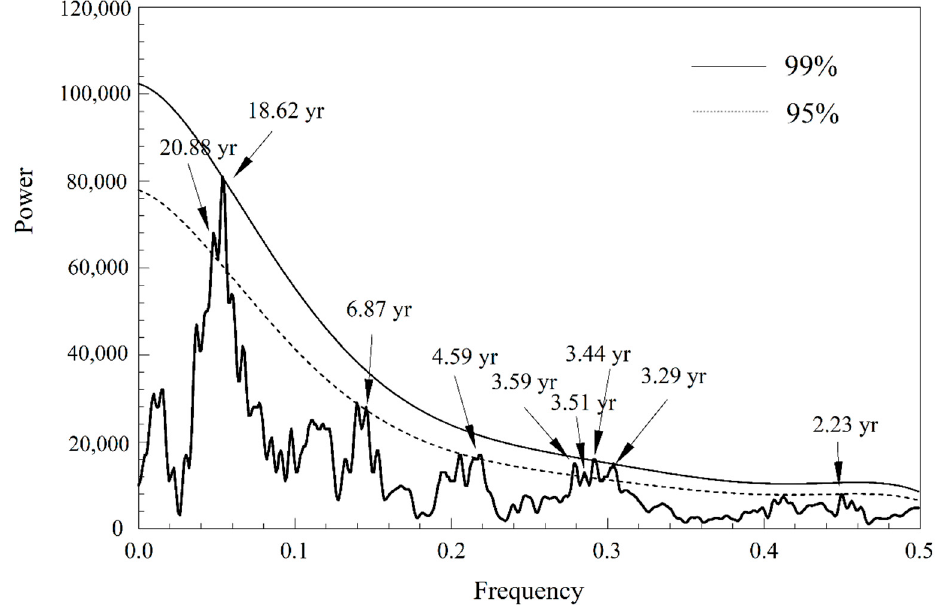
Figure 8. Multi-taper method (MTM) analysis results. Multi-taper method (MTM) spectral estimates of the reconstructed CNDVI JJ in the CW–DHM region from 1825 to 2013 CE, where the smoothed black solid and dashed lines represent red noise spectra at 99 and 95% confidence levels, respectively.